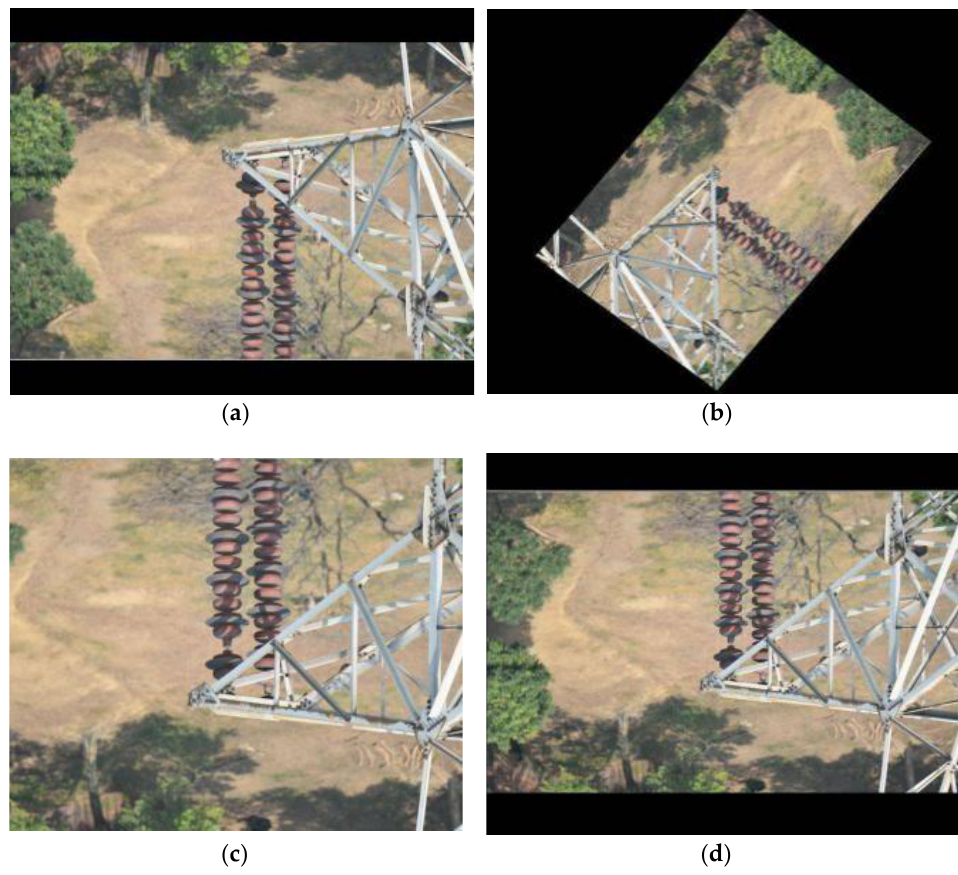
Figure 18. Examples of augmented images. ( a ) flipping. ( b ) random rotation. ( c ) random scaling. ( d ) reverse.